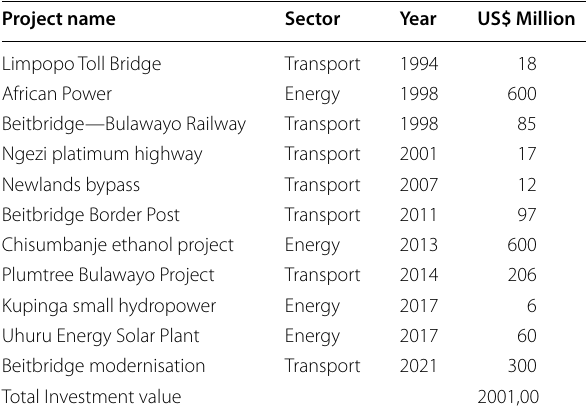
Table 1 Mega PPP that reached financial closure in